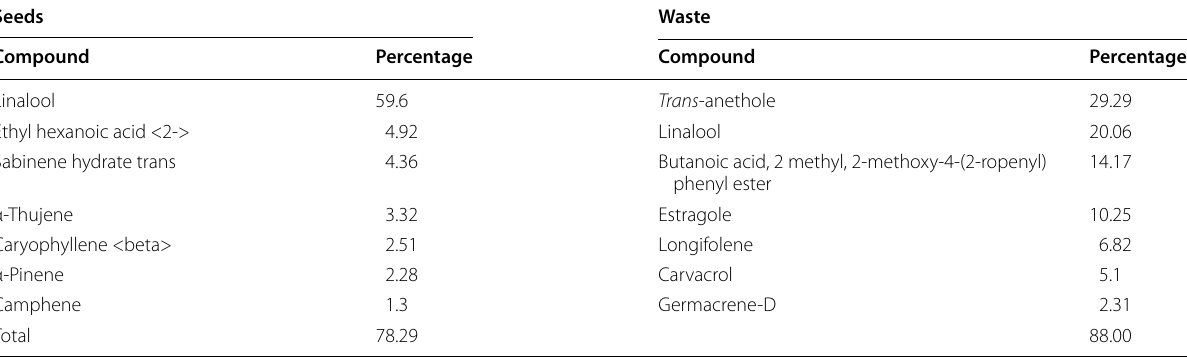
Table 1 Comparison between the major constituents of essential oil for both seeds and waste of coriander plant